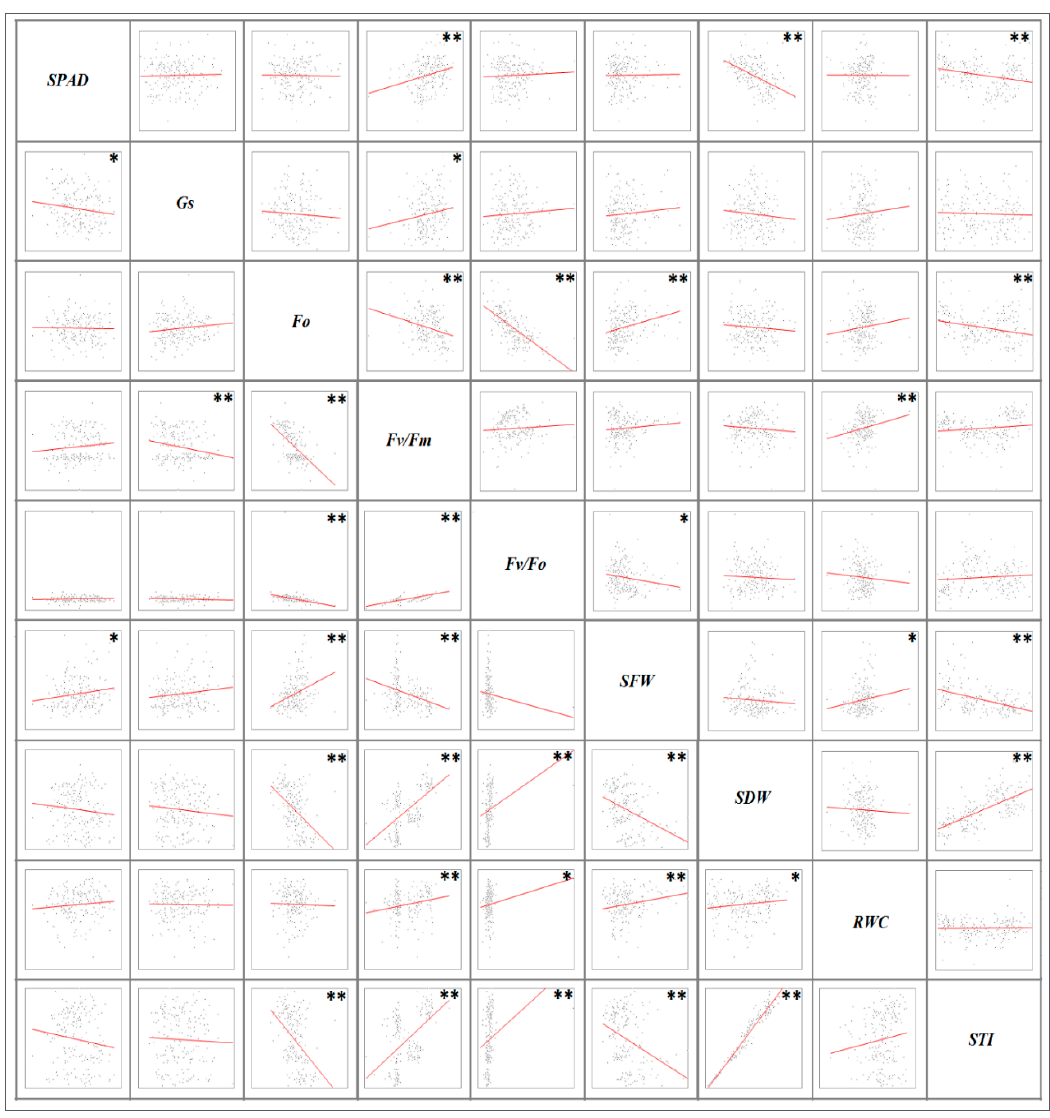
Figure 3. Pearson’s correlation coefficients among the different measured traits under control (above the diagonal) and water deficit stress conditions (below the diagonal). SPAD, Gs , Fo , Fv / Fo , Fv / Fm , SFW, SDW and STI indicate the relative chlorophyll content, stomatal conductance, initial fluorescence, maximum primary yield of photochemistry, maximum quantum efficiency, shoot fresh weight, shoot dry weight and stress tolerance index, respectively. * and ** show significance at the 0.05 and 0.01 probability levels, respectively; SFW, shoot fresh weight; SDW, shoot dry weight; RWC, relative water content; STI, stress tolerance index.